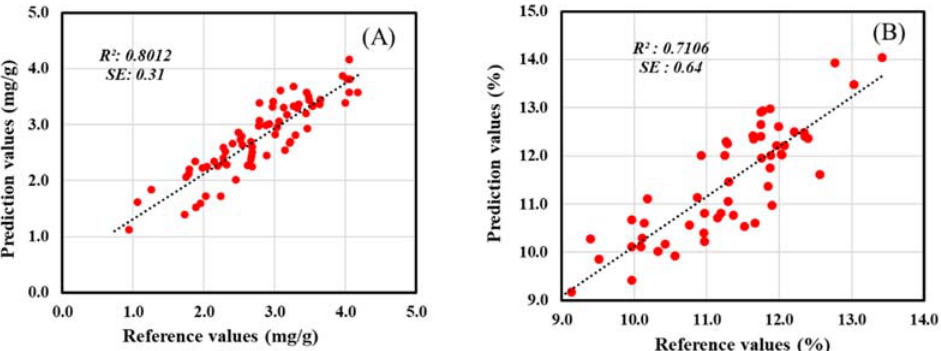
Figure 6. The distribution of the prediction data correlated with reference for the testing procedure using FT-NIR technique: ( A ) total isoflavones; ( B ) total